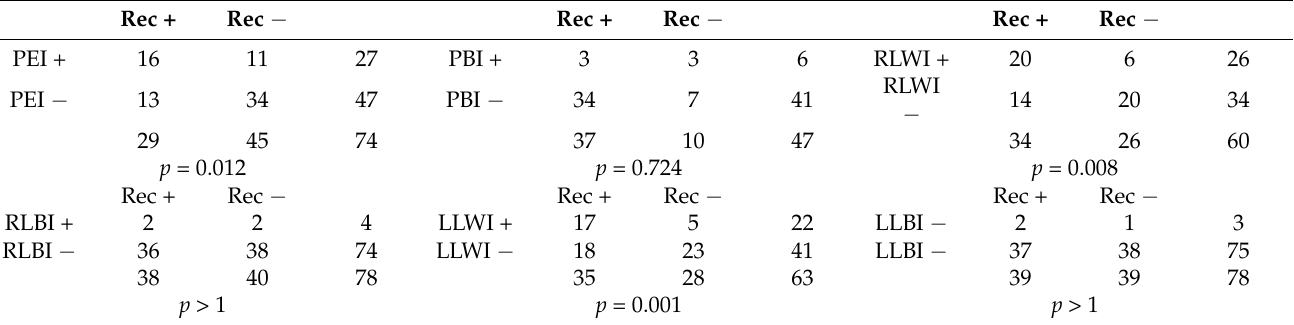
Table 4. Contingency tables and p -value for chi-squared